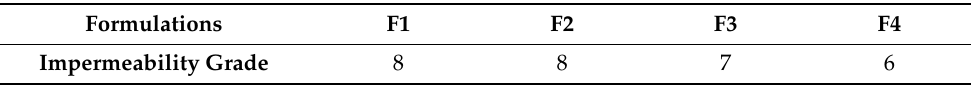
Table 5. Impermeability of SN-modified underwater composite-repairing materials.